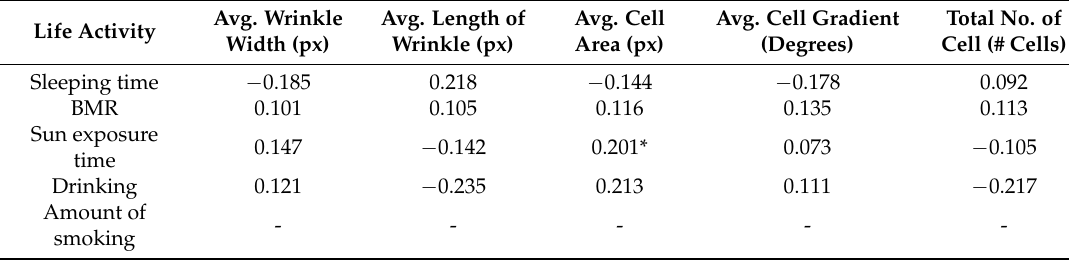
Table 3. Pearson correlation coefficient (subject